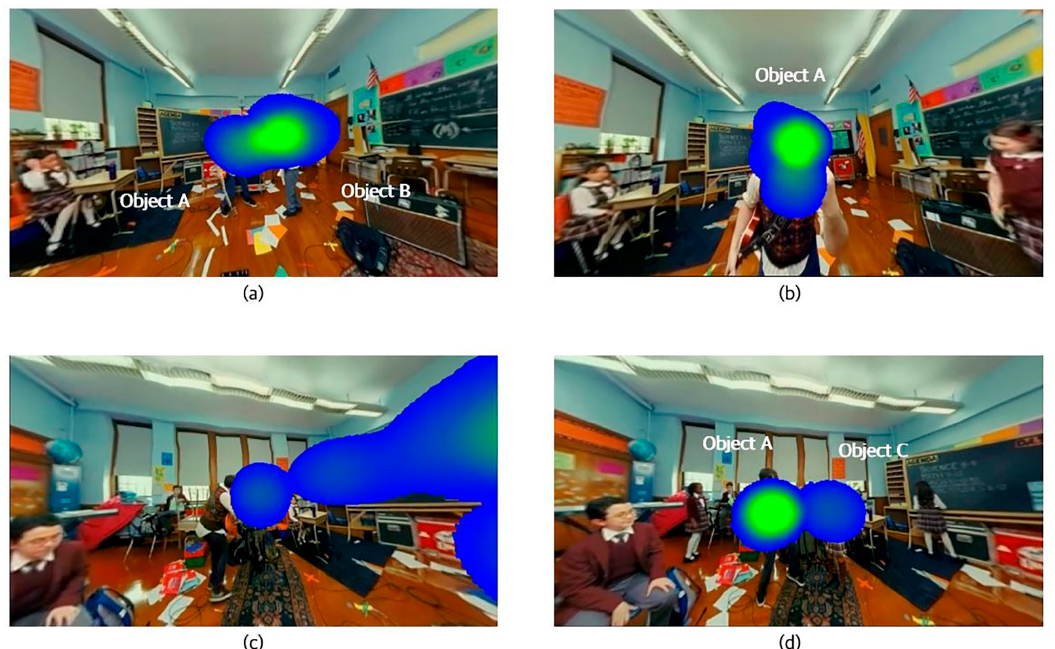
Figure 16. Eye movement according to attention-attracting element of “Object movement”. ( a ) The subjects focused their attention on objects A and B, ( b ) Object A starts to move, ( c ) The subject’s attention moves along object A, ( d ) The subject’s attention moves to the position where object C was positioned.